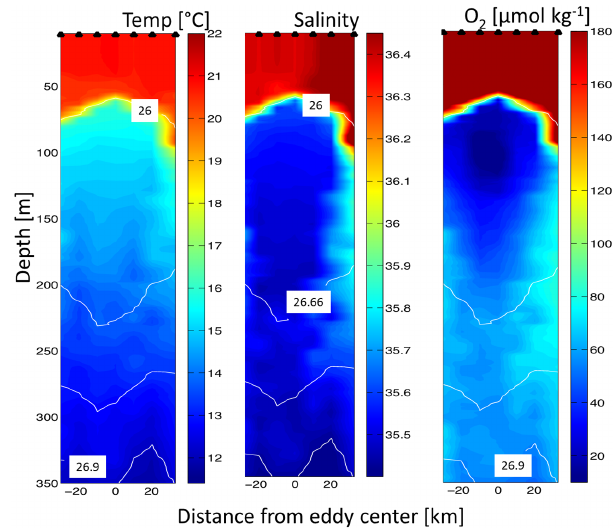
Figure 2. Temperature (left panel), salinity (middle panel) and O 2 concentration (right panel) measured during a section of R/V Meteor Cruise M105 across the studied eddy. Minimum O 2 was 4.8µmolkg − 1 at ∼ 100m water depth on that section; however, even lower O 2 was detected with a glider (1.2µmolkg − 1 ) . Isopy- cnals are indicated by white